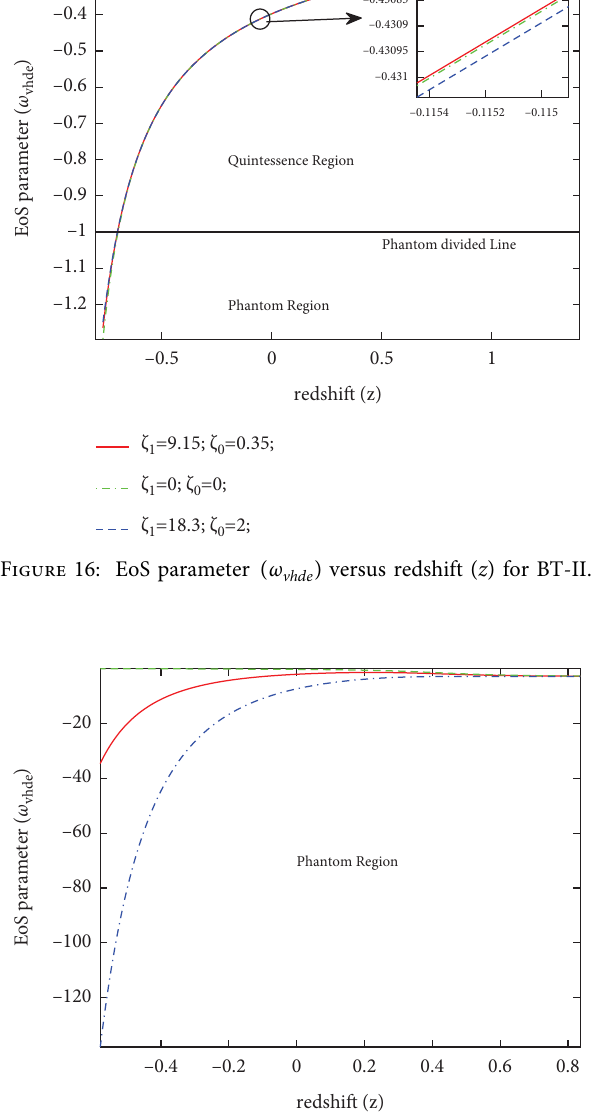
)( ω ) versus redshift ( z ) for vhde vhde